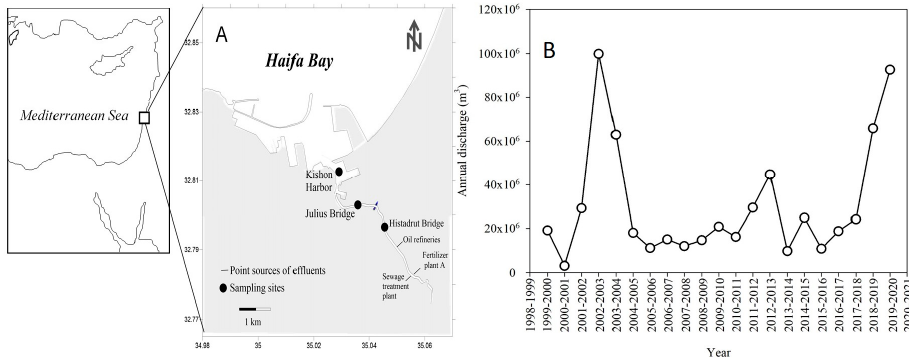
Figure 1. A map showing the sampling locations (Kishon Harbor; Julius Bridge; Histadrut Bridge, both ~1.4 and ~2.9 km upstream of the harbor station, respectively) at the lower reach of the Kishon River estuary between 2002–2021 ( A ), and the annual discharges at the estuary (data source: Israeli Water Authority Hydrological Reports) ( B ).